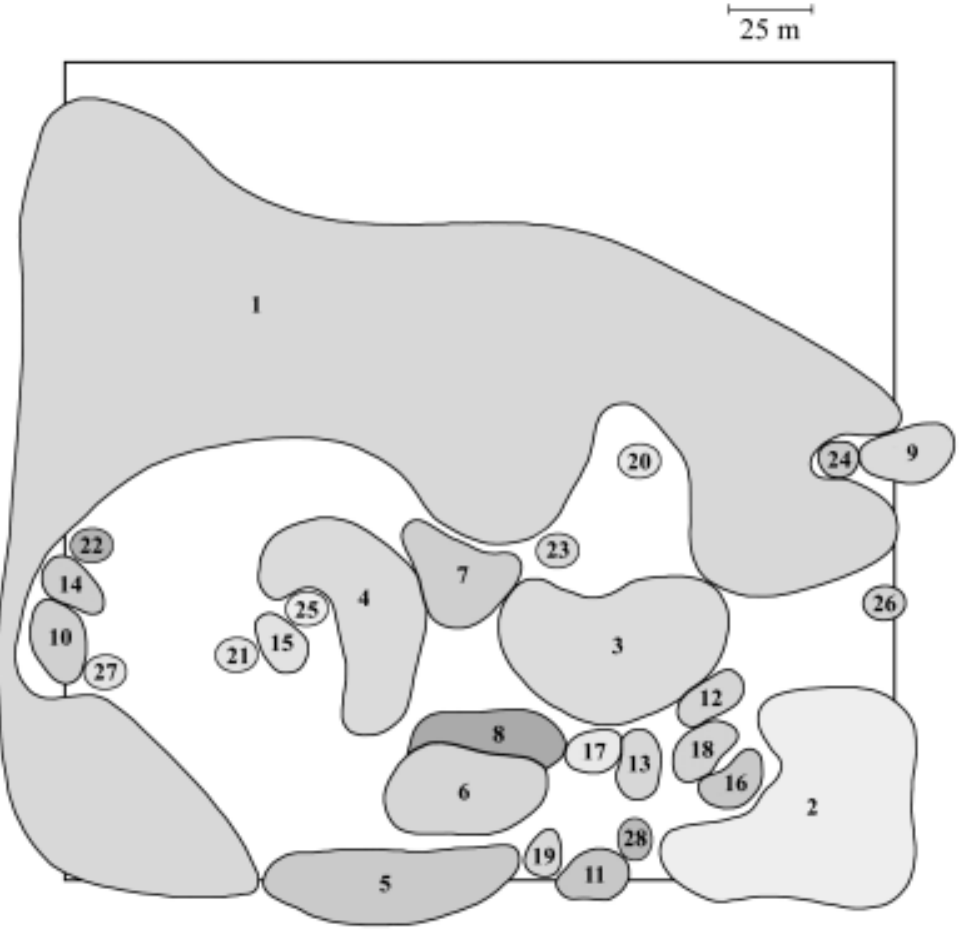
Fig. 1. Distribution of the 28 genets of A. gallica detected in the 6.25 ha test site at the Difesa Grande oak wood, Gravina in Puglia, southern Italy (lines do not precisely demarcate the spatial limits of mycelium of each